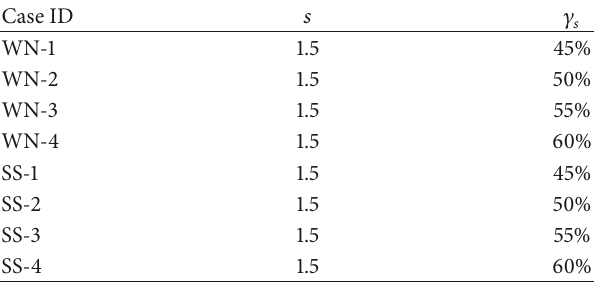
Table 1: Design cases for the hybrid-controlled